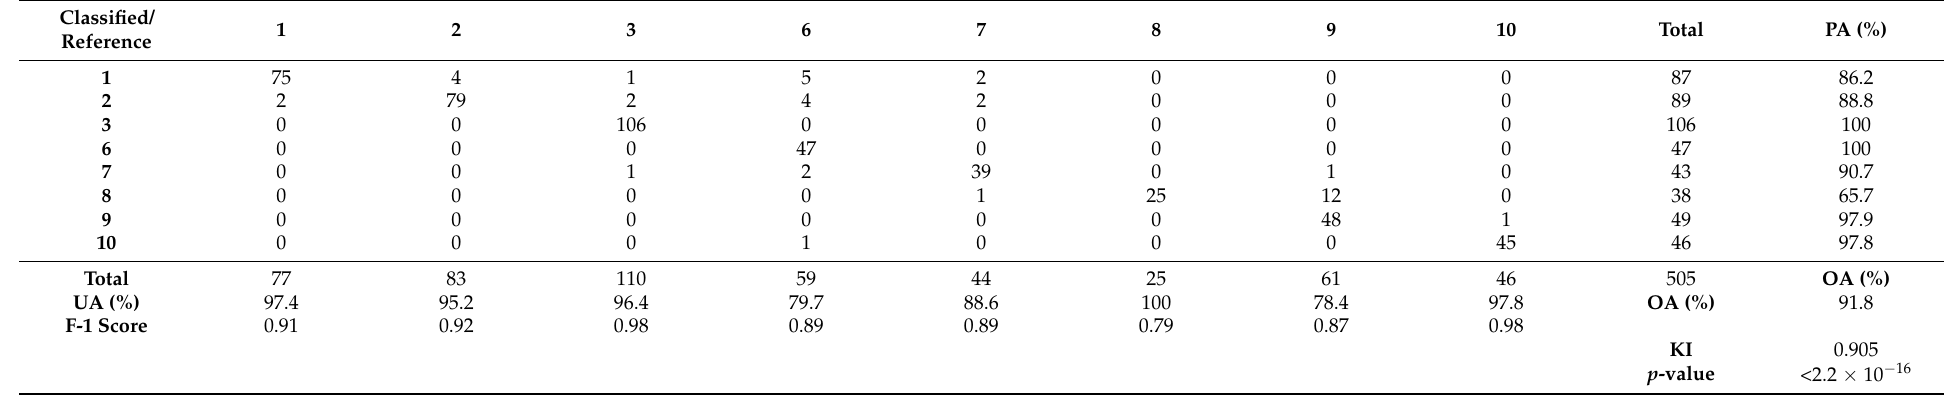
Table 5. The Confusion matrix obtained for the final classification of the TNH tile produced using the Plurality voting aggregation method. Producer’s Accuracy (PA), User’s Accuracy (UA), Overall Accuracy (OA), F-1 score (F-1), Kappa Index (KI) and its derived p -value ( p -value). Classes: Eucalyptus spp. (1), Conifers (2), Broadleaves (3), Crops and pastures (6), Shrubs (7), Bare soil (8), Anthropogenic areas (9) and Water (10).